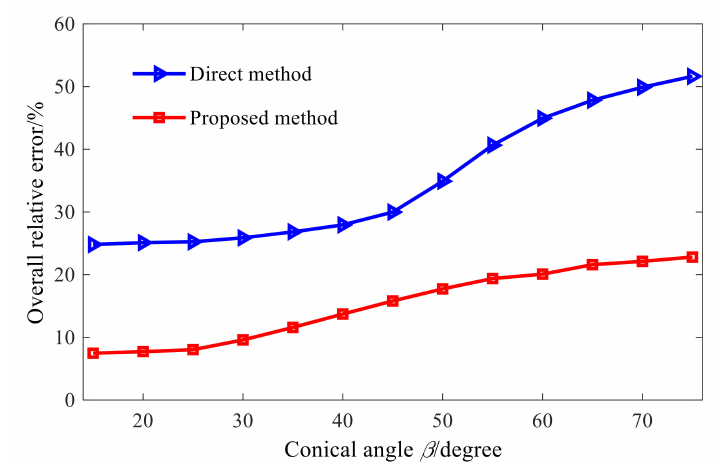
Figure 11. Overall relative errors of the two